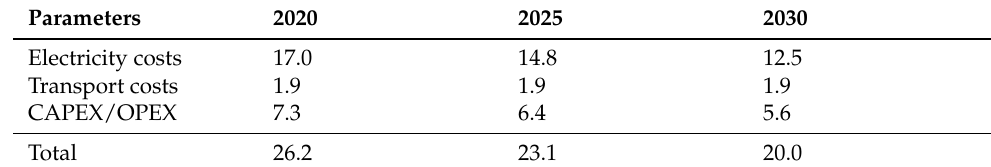
Table A3. Price components of green hydrogen produced in Germany according to [71].